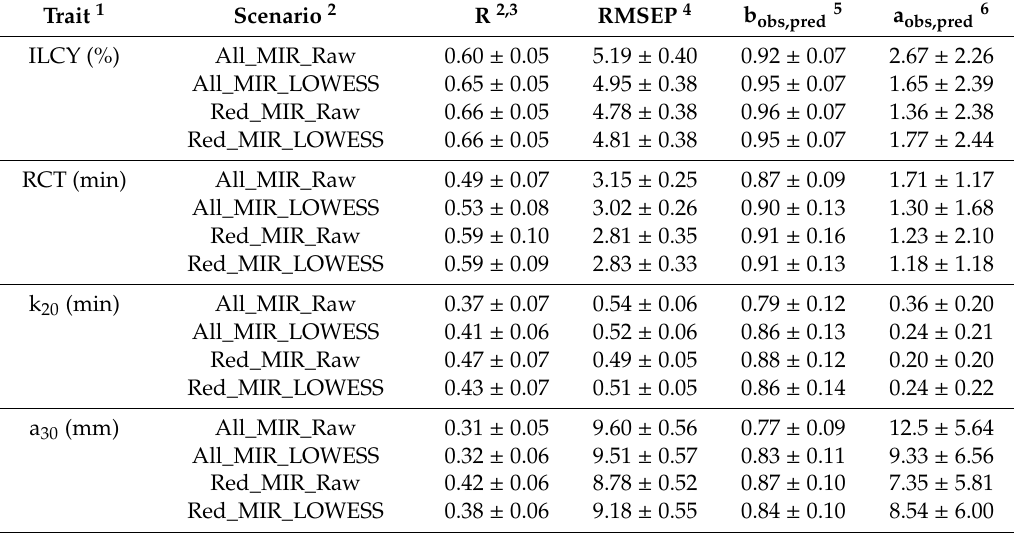
Table 2. Statistics of partial least square predictions for milk coagulation properties and individual laboratory cheese yield in the validation dataset averaged for 100